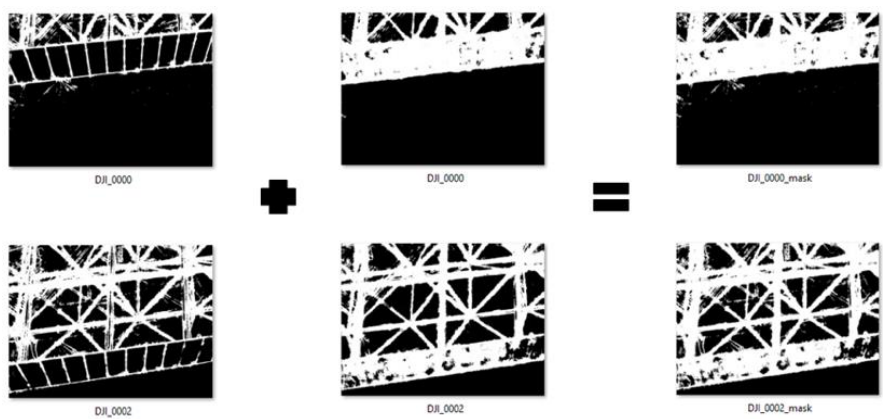
Figure 27. Masks resulting from the sum of the third attempt with those of the second attempt.